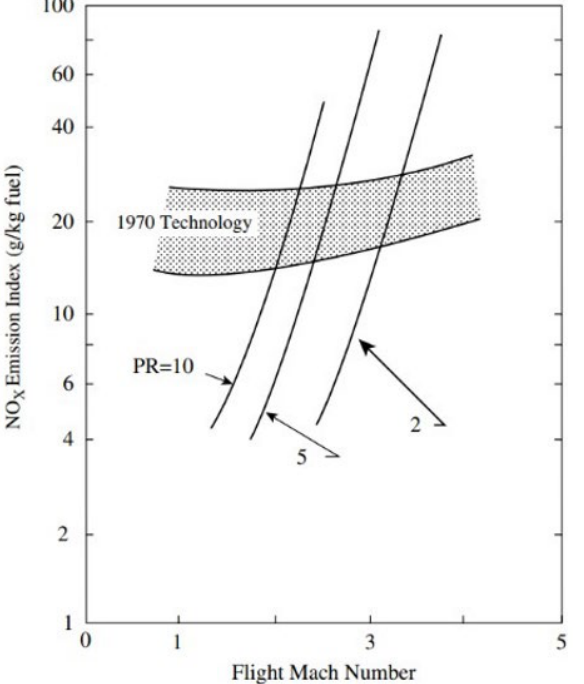
Figure 2. The impact of flight Mach number on NO x emissions considering different pressure ratios (PR) [31].